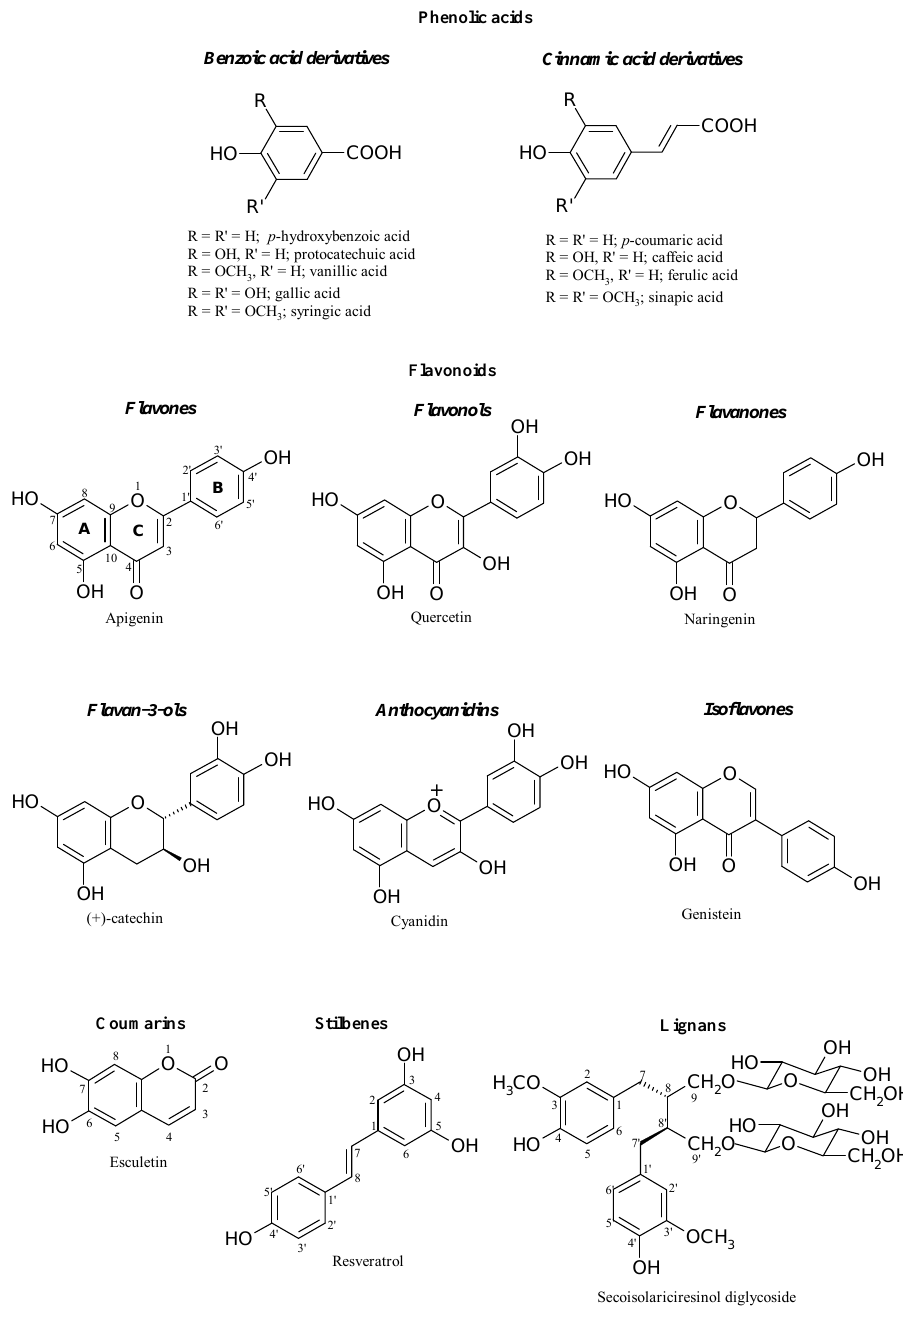
Figure 2 . Main classes of phenolics (from